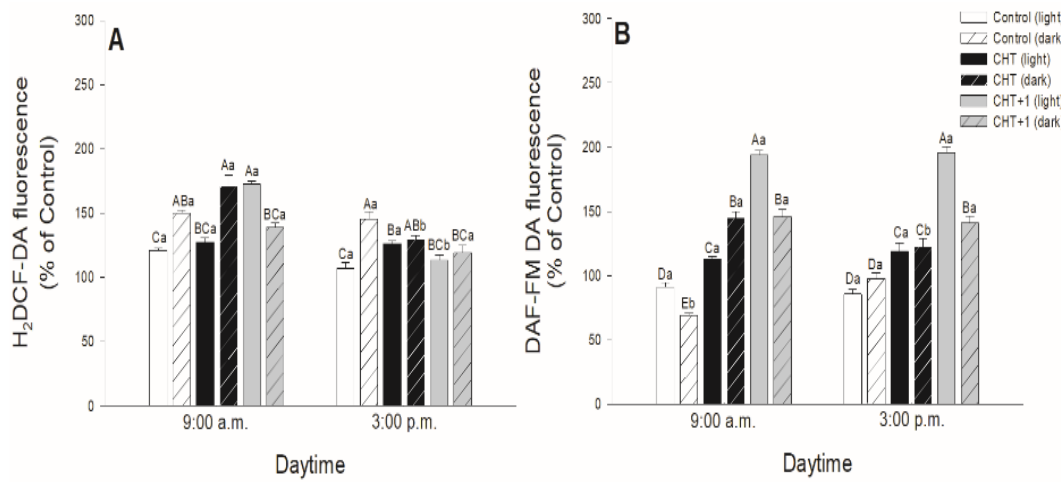
Figure 4. Changes in the production of ROS (A) and NO (B) in stoma on the abaxial epidermal strips of intact tomato plants treated foliar with 100 μg mL -1 chitosan (CHT) dissolved in the experimental buffer (1 mM AA, 10 mM MES/TRIS, 10 mM KCl, 0.1 mM CaCl 2 , pH 6.15) in the morning, keeping under light (normal columns) or in continuous darkness (stripped columns)]. Measurements were disposed at constant times after treatments (09:00 and 15:00 hrs). Means ± SE, n = 3. Means were analyzed by two-way ANOVA, significant differences among the data were analyzed by Holm–Sidak test. Mean values significantly different at P < 0.05 were signed with different letters, upper case letters indicate the effects of the treatment at the same daytime, and lower case letters indicate the effects of the daytime under the same treatment. (Control: treatment with 1 mM Acetic acid buffer (AA); CHT: treatment with 100 μg mL -1 chitosan in experimental buffer containing AA; CHT+1: untreated distal leaf level from the CHT-treated one).